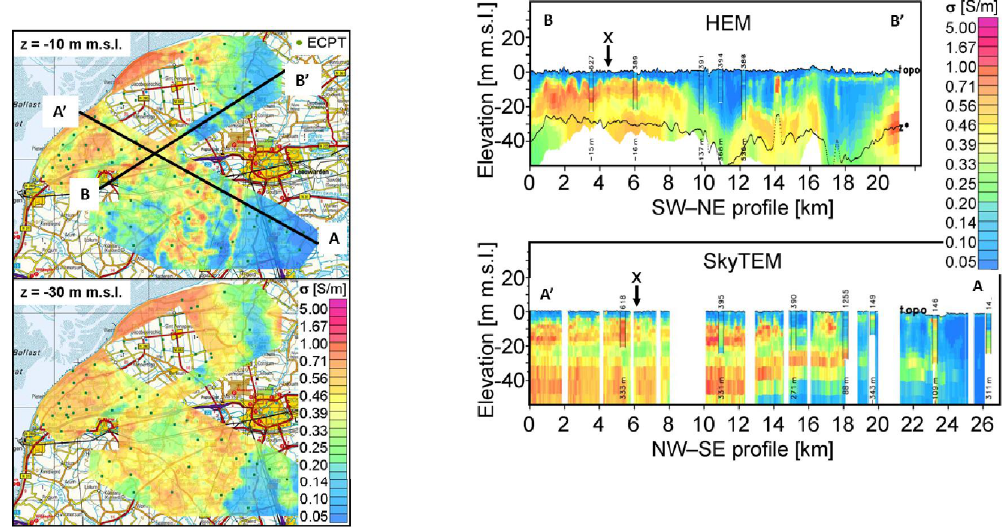
Fig. 4. Depth slices and cross-sections of EC (total) from the AEM models. Figure 4 Depth slices and cross-sections of EC(total) from the AEM models